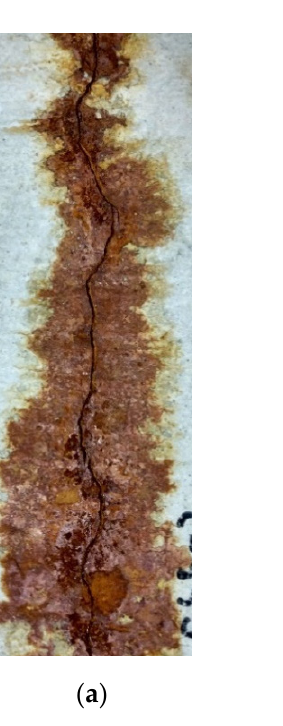
Figure 5. Schematic diagram of binary method conversion: ( a ) Original image of G6.5-2 crack; ( b ) Binary graph of G6.5-2 crack; ( c ) Binary matrix of G6.5-2 crack.